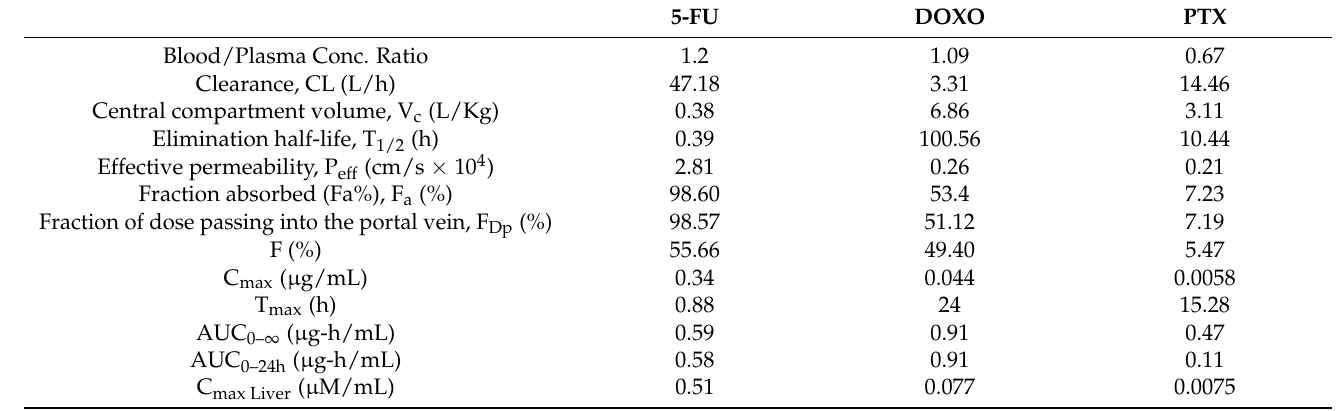
Table 1. Summary of simulated mean plasma PK parameters for GastroPlus ® simulations of 5-FU, DOXO, and PTX. The pharmacokinetic parameters are %F (% bioavailability), which is the percent of drug that reached the systemic circulation, T max , C max , and AUC (area under the curve).